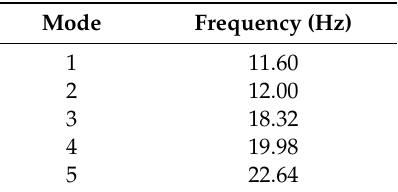
Table 2. Frequencies for 5 dynamic eigenmodes.